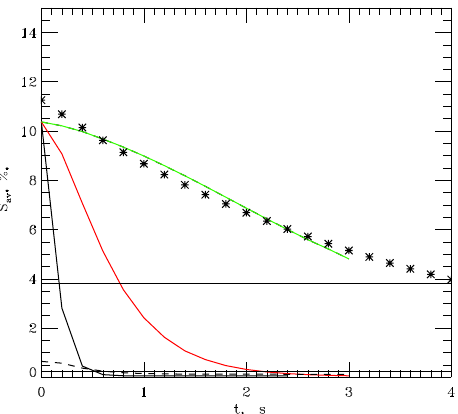
Figure 10. The dependence of count mean diameter (CMD) on time for case 1 (green solid curve), case 2 (red solid curve), case 3 (black solid curve), case 4 (black dashed curve).